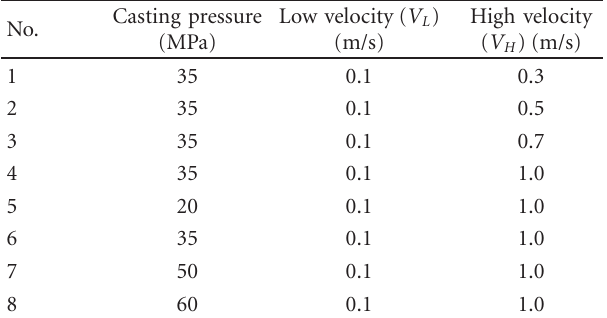
Figure 7: Photographs of arm part according to velocity and pressure (at 75% solid fraction): (1) 0.2m/s and 300bar; (2) 0.3m/s and 300 bar; (3) 0.3m/s and 450bar; (4) 0.5m/s and 450bar. Table 1: The conditions of rheo-casting process.